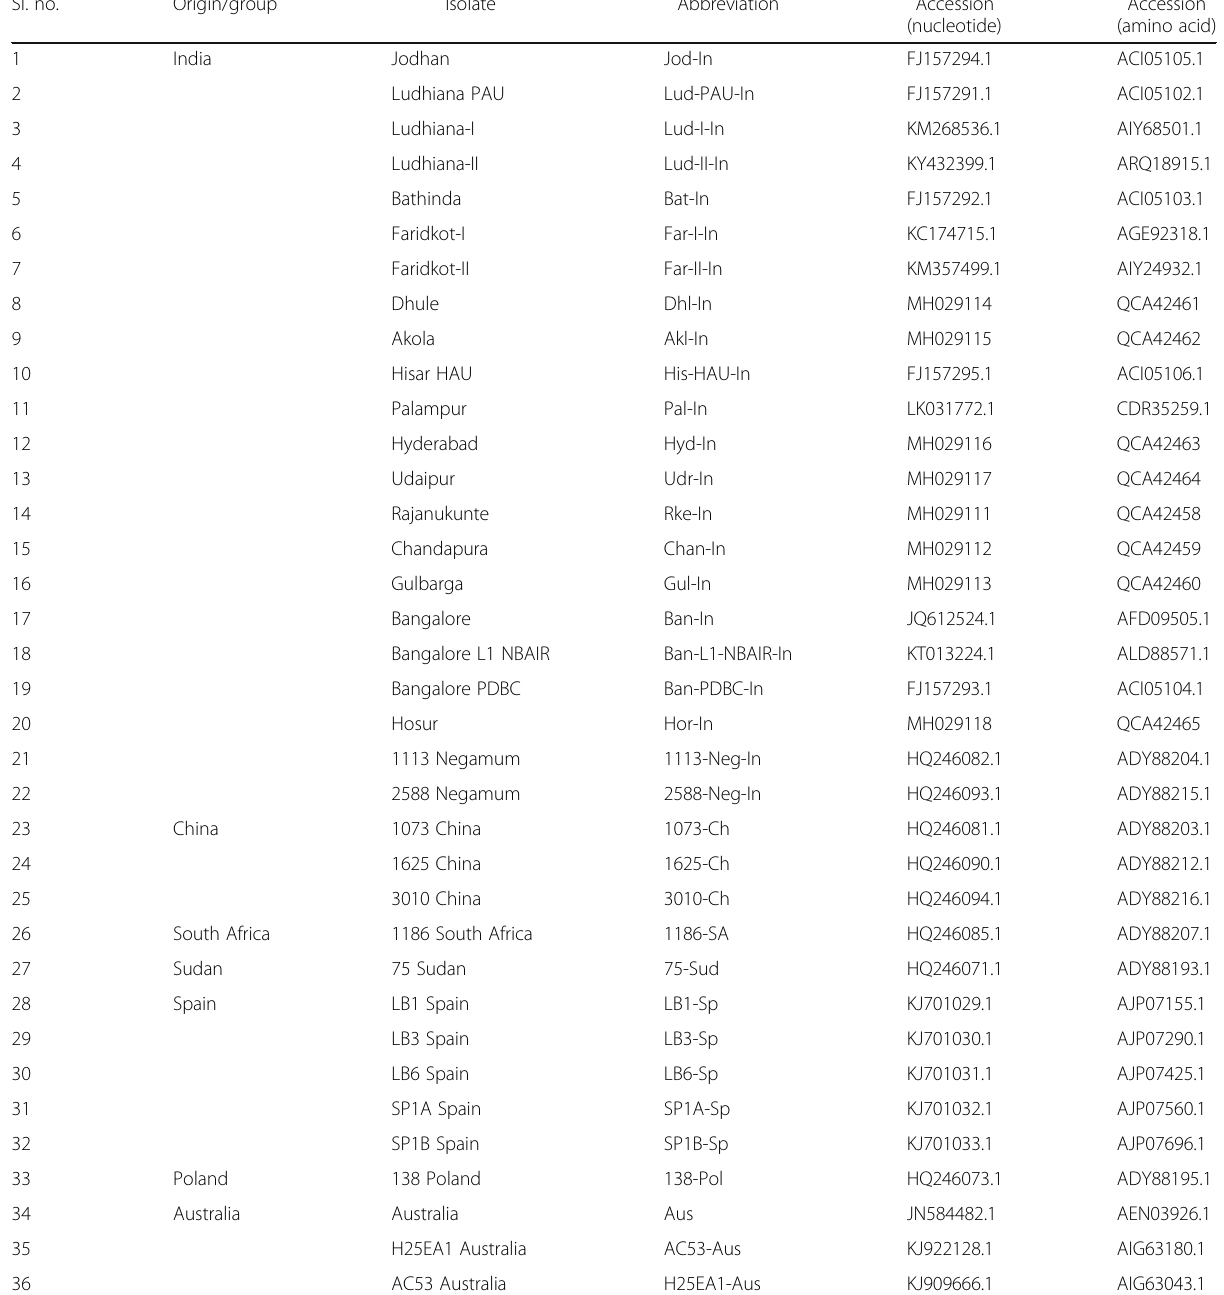
Table 2 Geographical isolates of Helicoverpa armigera nucleopolyhedrosis virus ( Hear NPV) used to compare with the eight isolates from present study Sl.